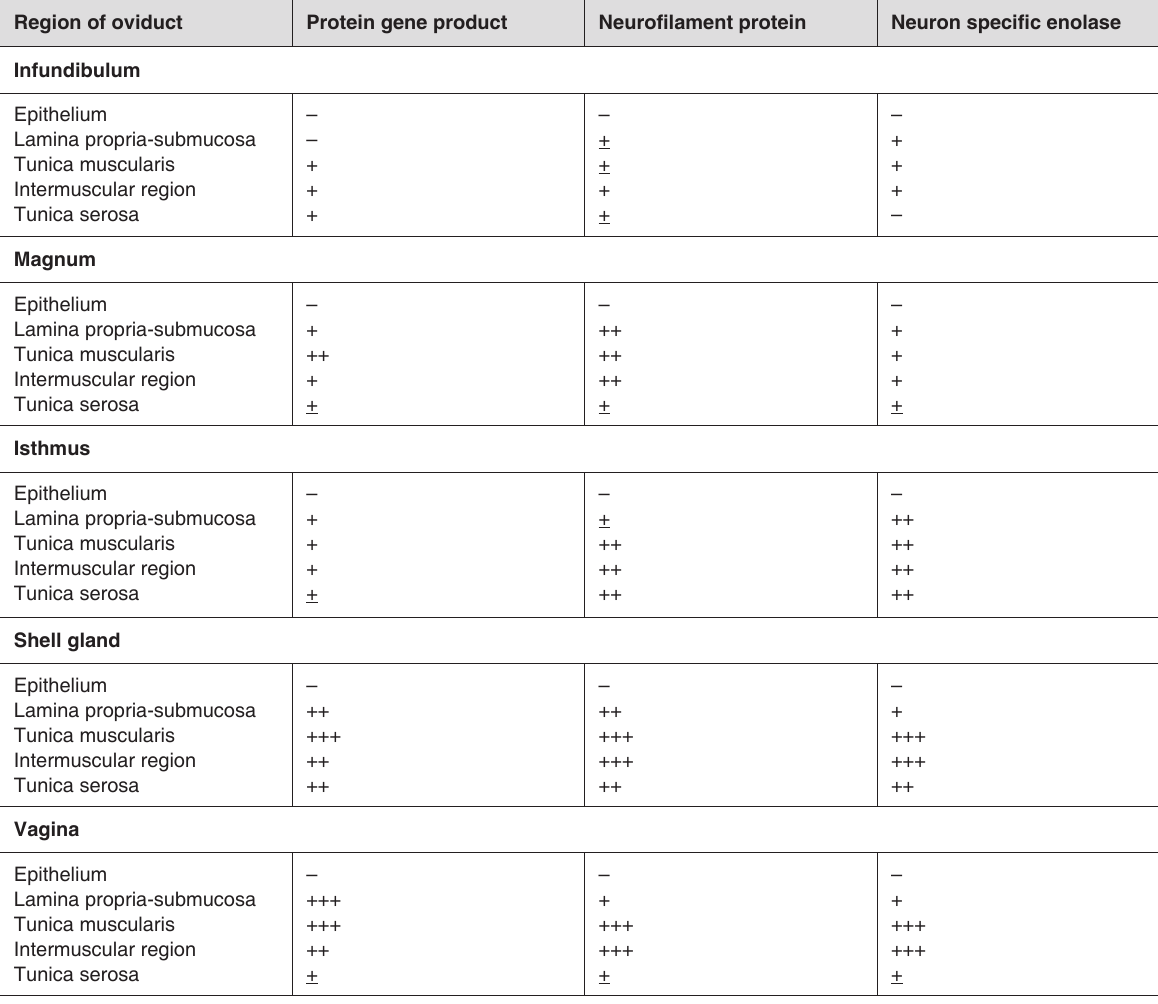
TABLE 1 Relative frequency and distribution of protein gene product 9.5 (PGP)-, neurofilament protein (NP)- and neuron specific enolase-immunoreactive nerves in the oviduct of the